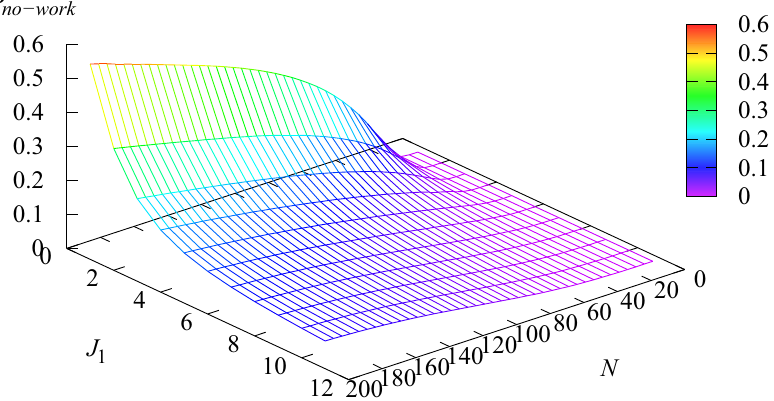
Figure 5. Dependence of the probability P no - work on N and J 1